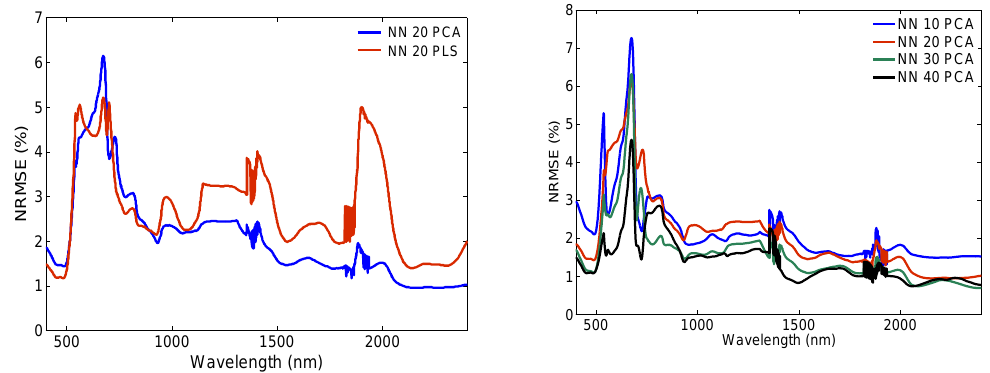
Figure 3. Left: SCOPE NRMSE [%] results for the NN validation for 30% of 500 SCOPE R spectra and using 20 components conversion for PCA and PLS. Right : SCOPE NRMSE [%] results for the NN validation for 30% of 500 SCOPE R spectra for PCA using 10, 20, 30 and 40 components